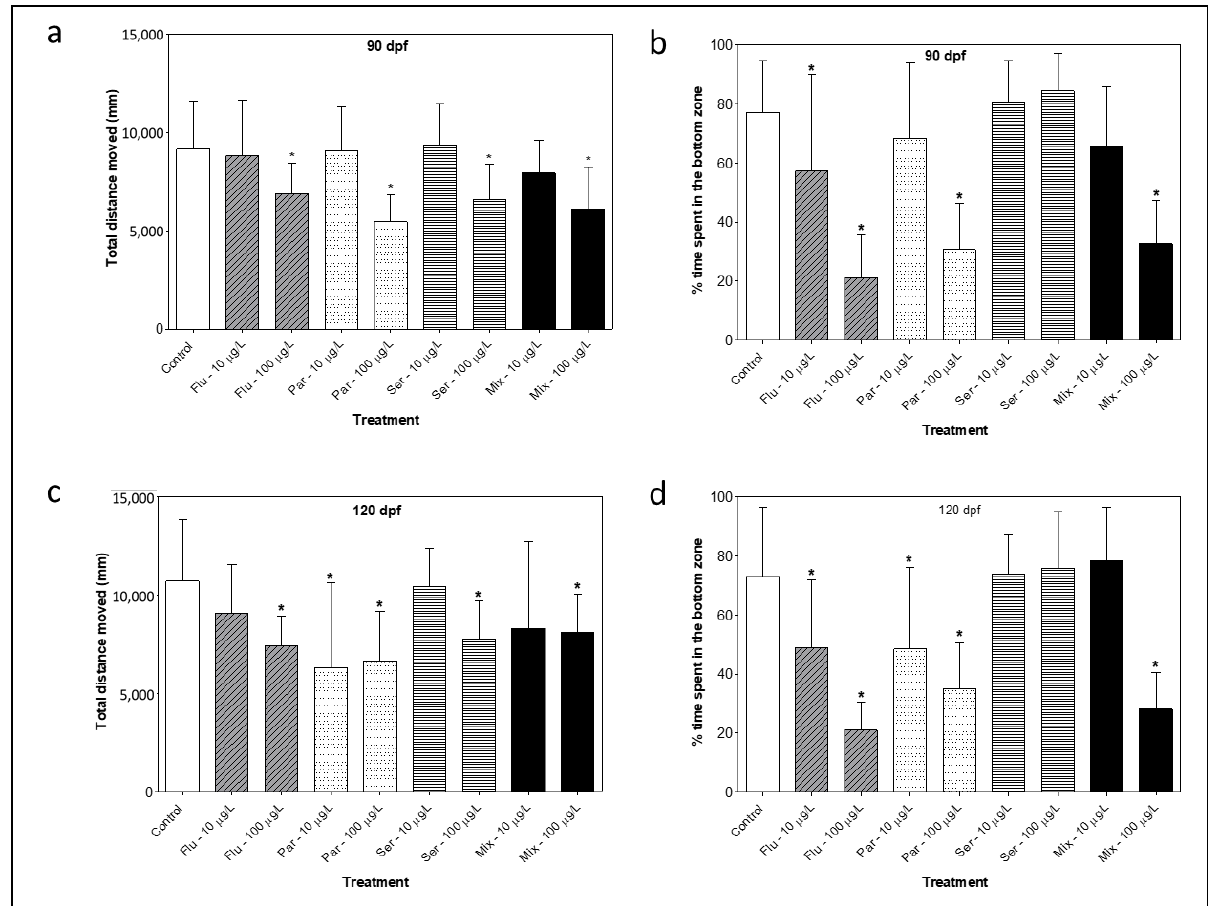
Figure 4. At 90 and 120 days post fertilization (dpf) , total activity of fish during 6 min experiments quantified as the total distance moved (mm) ( a , c ) and % time spent by fish in bottom zone of the tank during 6 min experiments ( b , d ). (Flu—Fluoxetine, Par—Paroxetine, Ser—Sertraline, Mix—mixture of all three compounds). Statistical significance with respect to the control fish group was de-